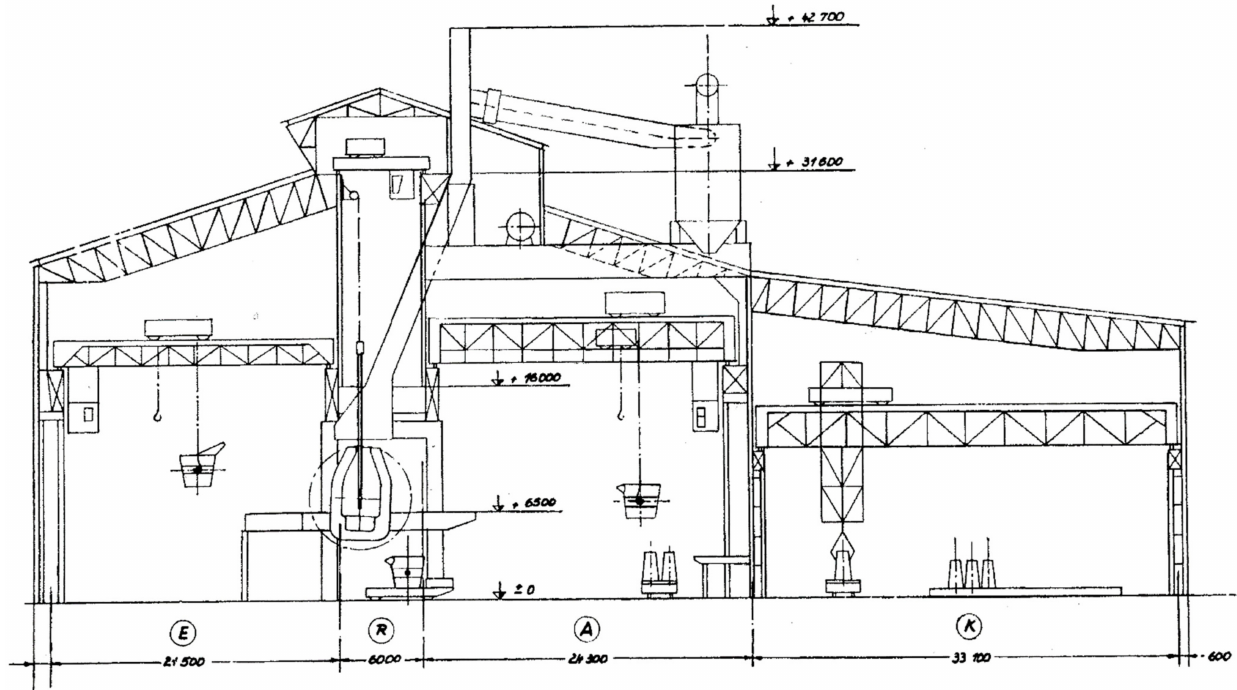
Figure 2. Section view of the SK steelmaking plant of ÖAMG in Donawitz in 1953. Reprinted with permission from Ref. [8], 2022, Voestalpine